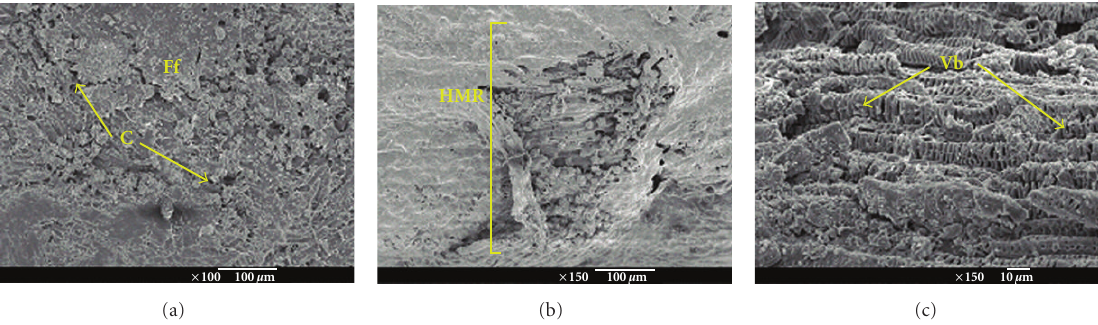
Figure 6: Micrographs of Opuntia tomentosa seeds exhumed after 5 months of burial and laboratory storage for 2 years. (a) Deep degradation of the funicular flanks in seeds buried at the open site, (b) cracks in the hilum-micropylar region, (c) degraded and eroded funicular envelope exposing the vascular bundles. C: cracks, Ff: funicular flanks, Fg: funicular girdle, HMR: hilum-micropylar region, Vb: vascular bundles.